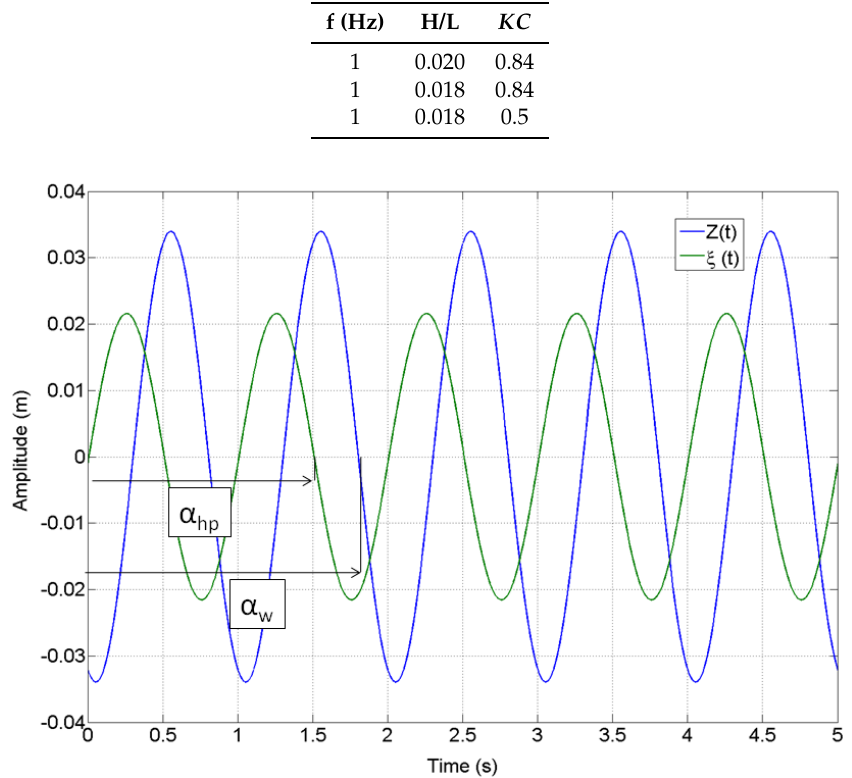
Figure 5. Wave and heave plate